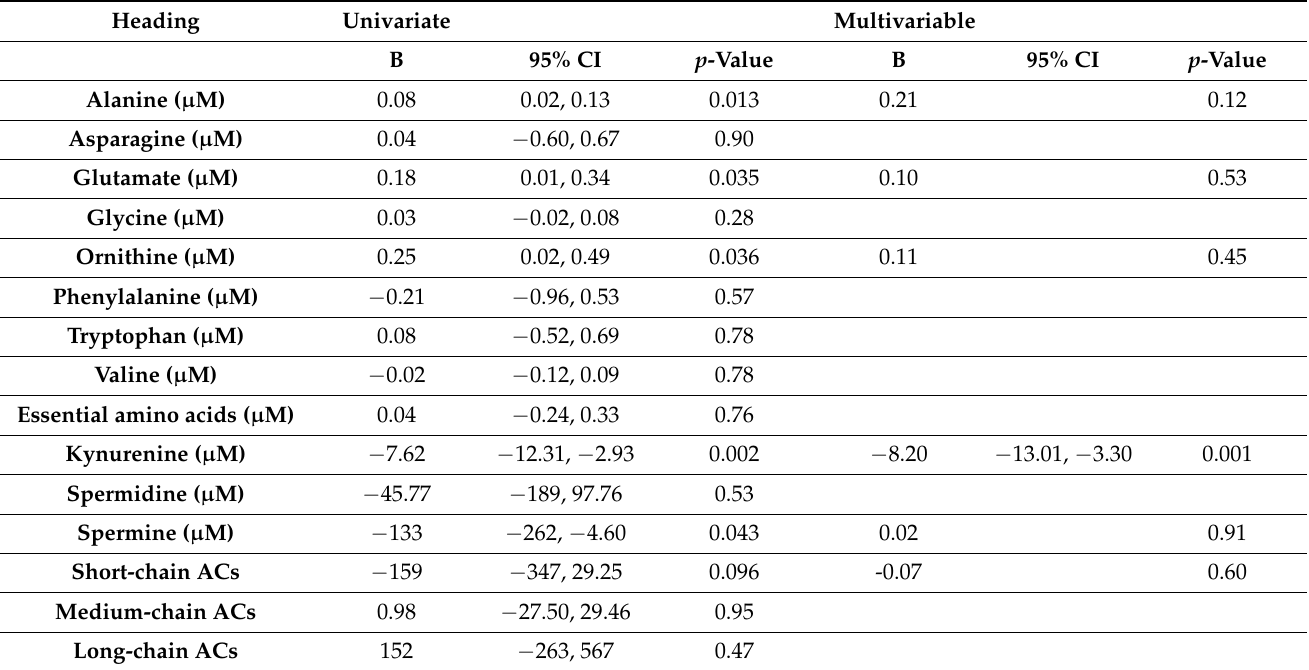
Table 5. Linear regression model with RME as the dependent variable.